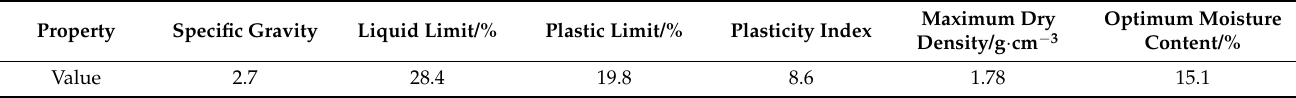
Figure 1. Size distribution of silt. Table 1. The basic physical index properties of silt soil.